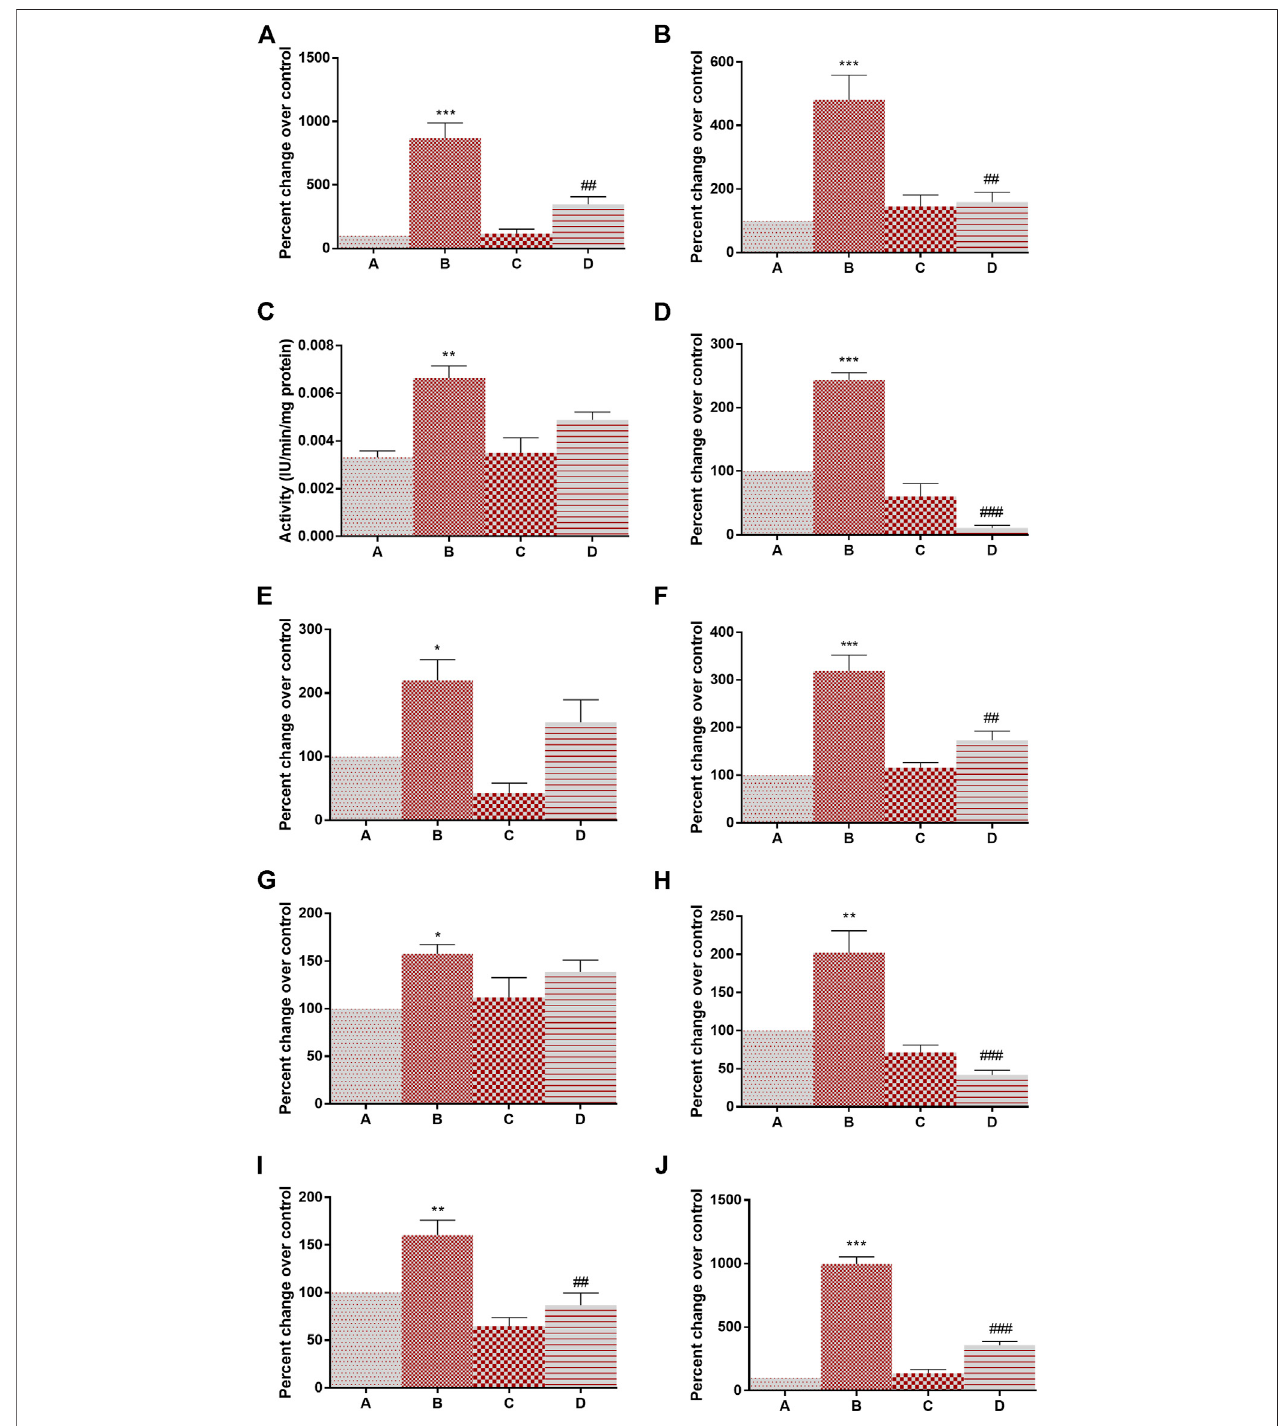
FIGURE 2 | Effect of 4-(methylthio)butyl isothiocyanate on gene expression analysis of glycolytic enzymes in the control and experimental group of animals. (A) Hexokinase, (B) Phosphoglucose isomerase, (C) phosphofructokinase, (D) Aldolase, (E) Triosphosphate isomerase, (F) Glyceraldehyde 3-phosphate dehydrogenase, (G) Phosphoglyceratekinase, (H) Phosphoglyceratemutase, (I) Enolase, (J) Pyruvatekinase.Allthevaluesarerepresentedasmean ± SEM(n (cid:1) 3).Signi fi cantlevelsare * p < 0.05, ** p < 0.01, *** p < 0.001 when compared with group A and # p < 0.05, ## p < 0.01 when compared with group B.